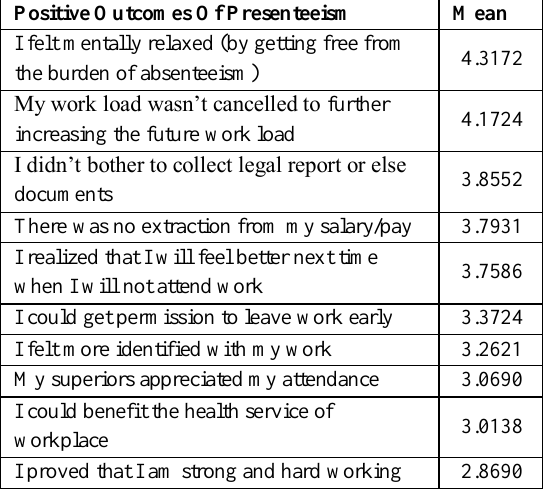
Table 9: Positive Outcomes of Presenteeism and Their Means Positive Outcomes Of Presenteeism Mean